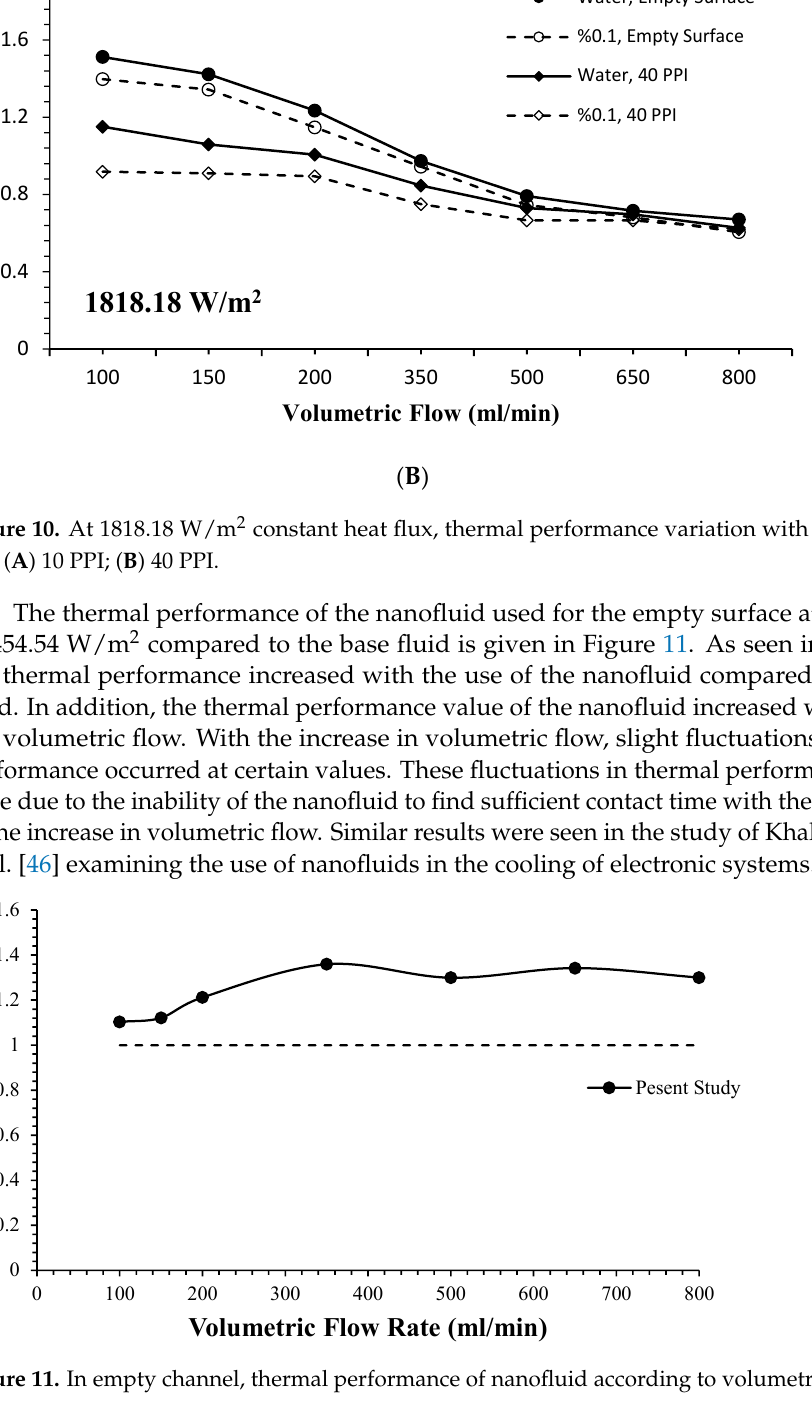
Figure 11. In empty channel, thermal performance of nanofluid according to volumetric flow.